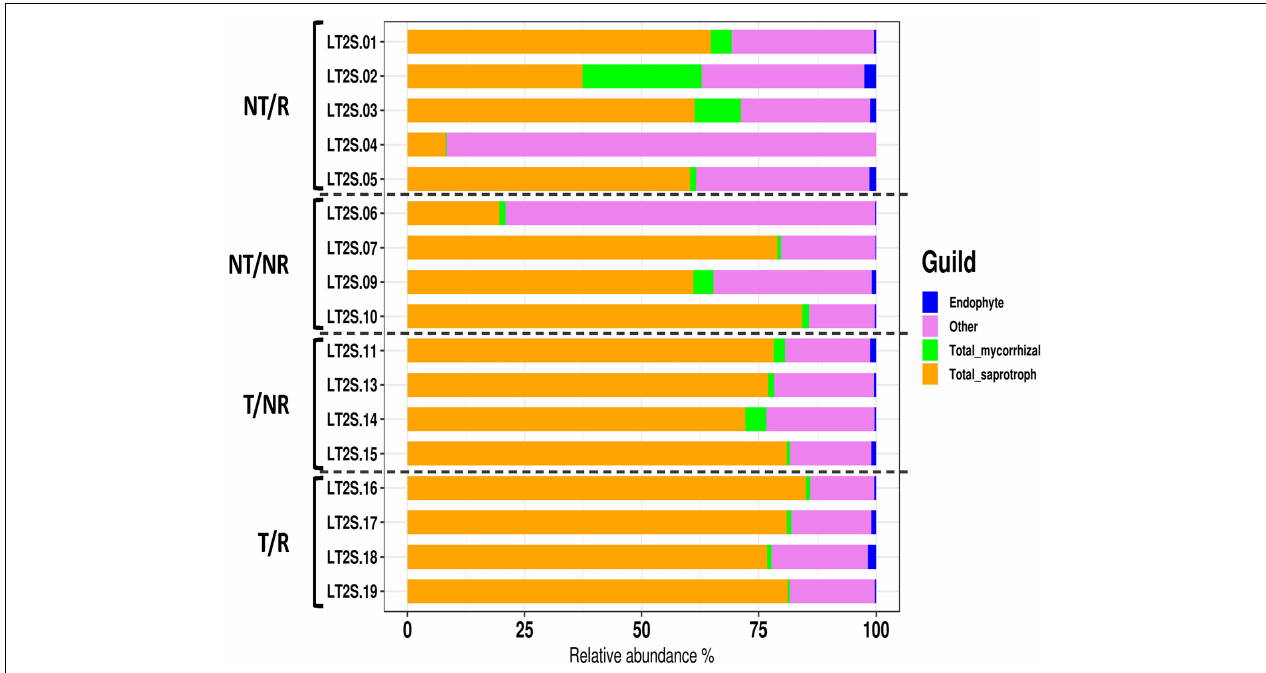
FIGURE 5 | FUNGuild was applied to characterize the OTUs traits and analyze if the different soil management systems impact the main fungal functional groups such as mycorrhizal, saprotrophic and endophytic fungi. The barplot shows the relative abundance of the endophytic, mycorrhizal and saprotrophic fungi in the different